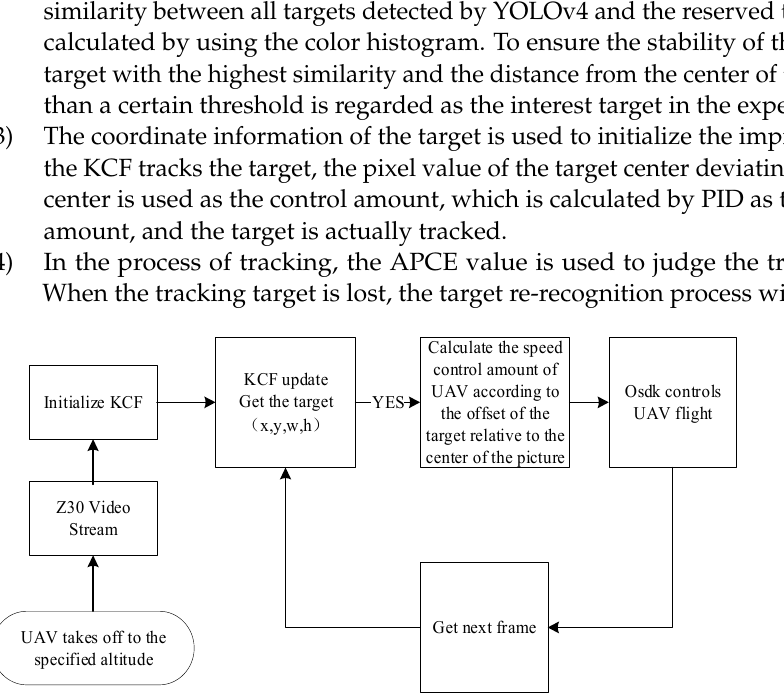
11 of 16 Figure 9. Experimental UAV platform. To verify the effectiveness of the algorithm, the experimental flow as shown in Figure